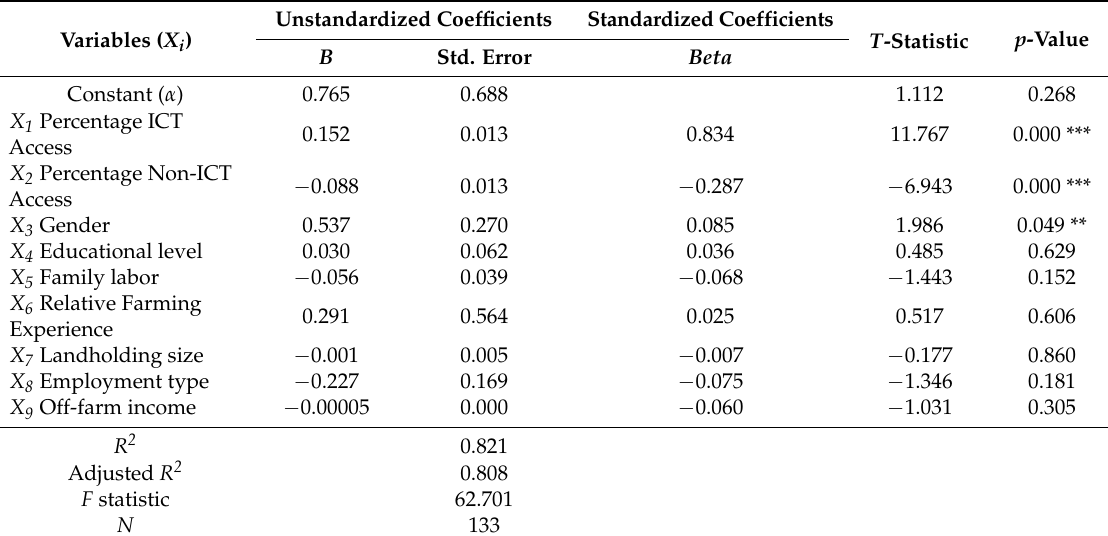
Table 8. Multiple regression results of the factors influencing level of access to marketing